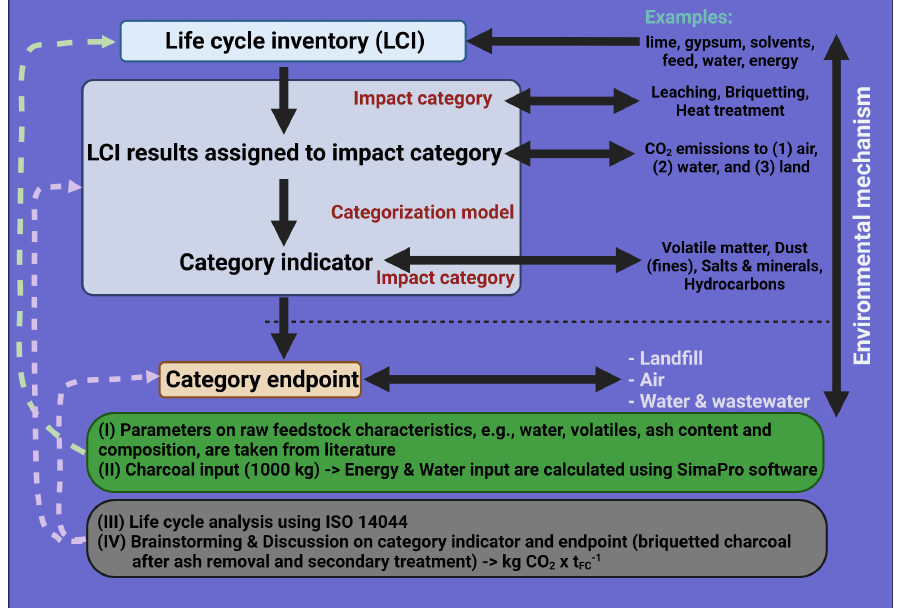
Figure 1. Schematic presentation of the used methodology based on ISO